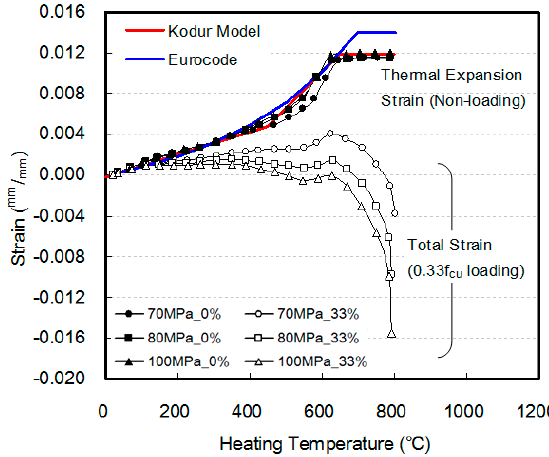
Figure 9. Thermal expansion and total strain of HSC.